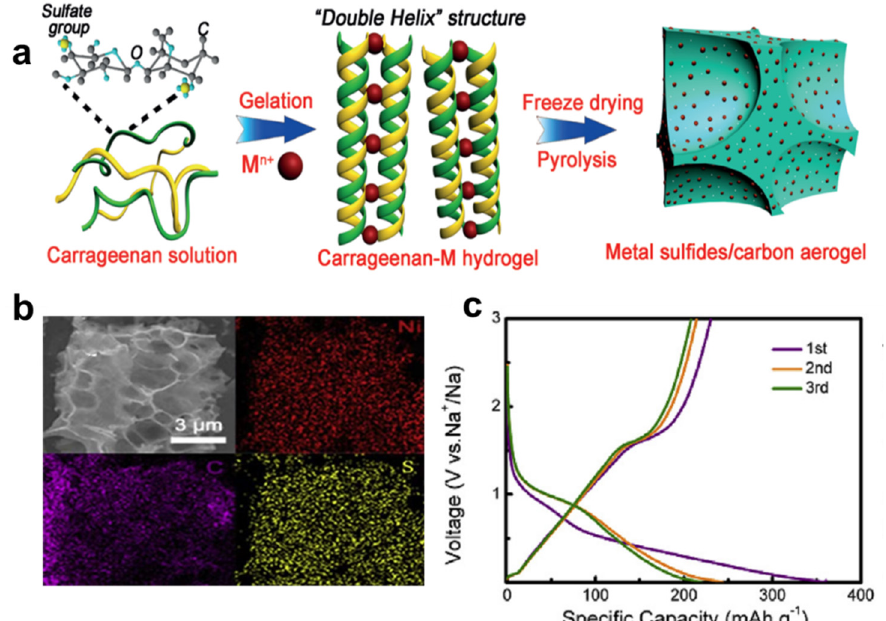
Figure 8. ( a ) Schematic illustration of double helix structure. Reprinted with permission from Ref. [117]. Copyright 2021 Wiley-VCH. ( b ) The EDS mappings of Ni, C, and S elements. ( c ) The Ni 3 S 4 /C cycled at the 1 st , 2 nd , and 3rd from 0.01 V to 3.0 V (vs. Na + /Na) at a current density of 1 A g − 1 . Reprinted with permission from Ref. [118]. Copyright 2019 Elcevier.